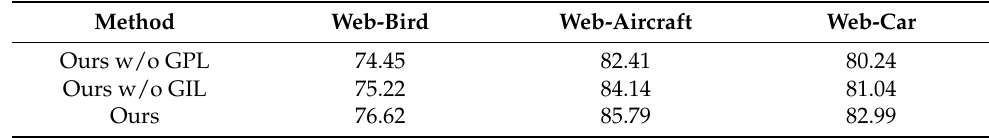
Table 3. Accuracies(%) of our GRML, our GRML that removes the graph interaction layer (Ours w/o intra-GPL) and our GRML that removes the graph interaction layer (Ours w/o GIL) on the three datasets.